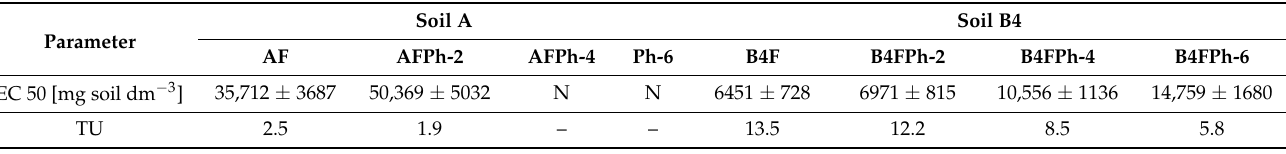
Table 4. Comparison of EC50 and TU values during phytoremediation carried out with M. officinalis , enhanced by fertilization of soils A and B according to the Microtox ® SPT test (repetitions number n = 5, p < 0.05).